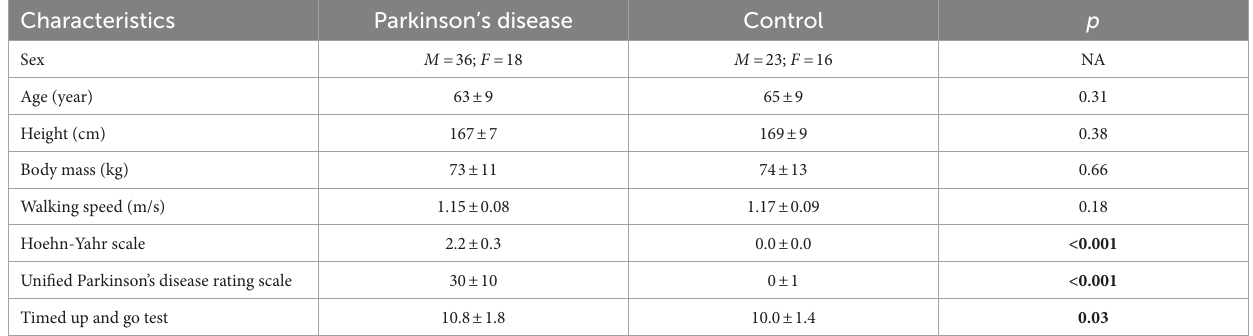
TABLE 1 Participant characteristics for Parkinson’s disease and control groups.